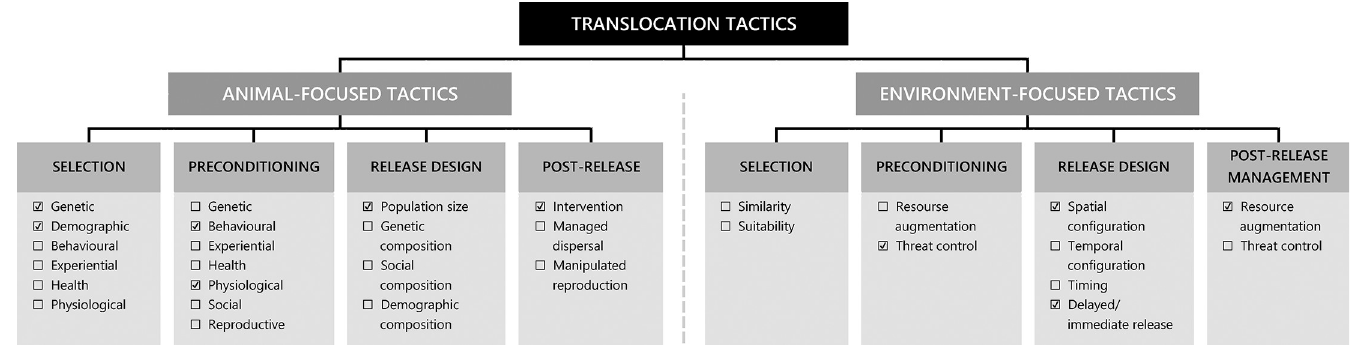
Fig 1. Translocation Tactics Classification System, as adapted from Batson et al . (2015). Checked boxes indicate tactics which were employed across the three trial reintroductions of the eastern quoll ( Dasyurus viverrinus ) to Mulligans Flat Woodland Sanctuary, ACT Australia from 2016–18.